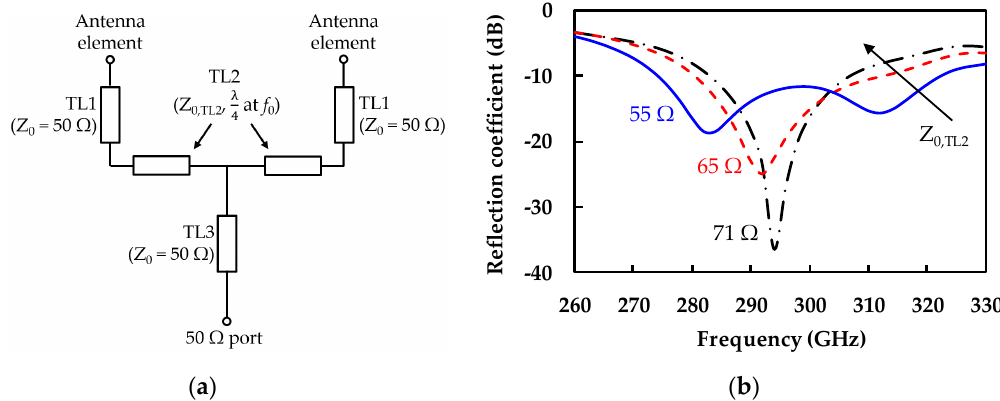
Figure 6. Design of feedlines of 1 × 2 antenna array. ( a ) Schematic. ( b ) Simulated reflection coefficient depending on characteristic impedance of feedline (Z 0,TL2 ).